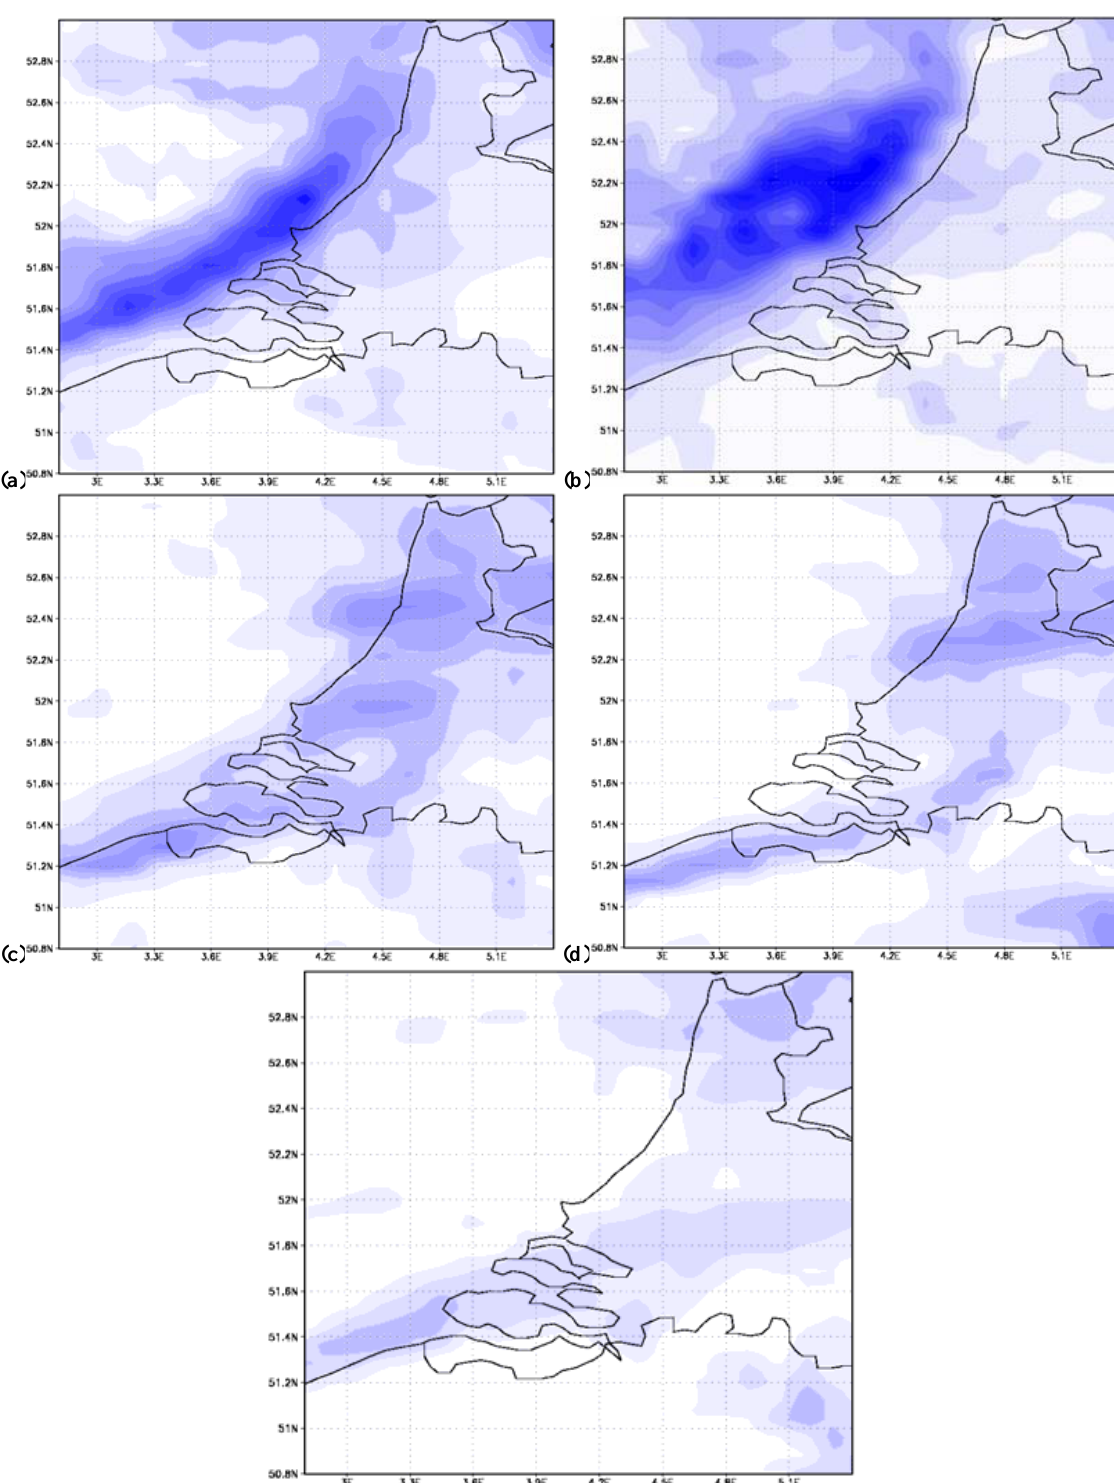
Fig. 13. Accumulated precipitation amounts (mm), produced by simulation 8 (a) , 9 (b) , 10 (c) , 11, (d) and 12 (e) over the time period between 12 August 12:00 UTC and 13 August 12:00 UTC. Specifications of the simulations are written in Table